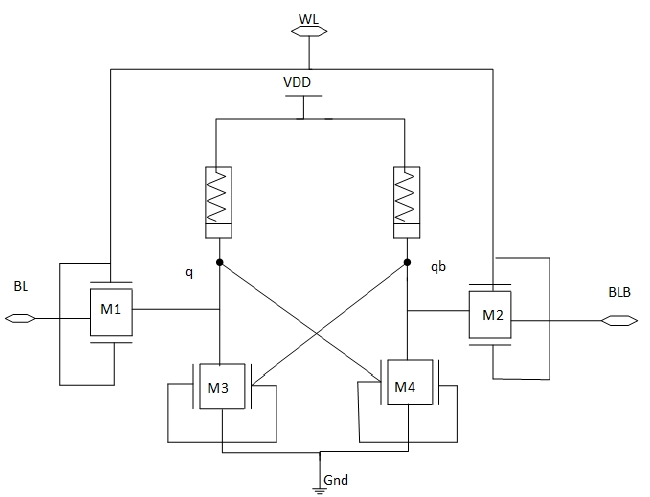
Figure 7. Silicon Substrate FinFET–Ti/ TiN Memristor based hybrid 6T ‐ SRAM design .